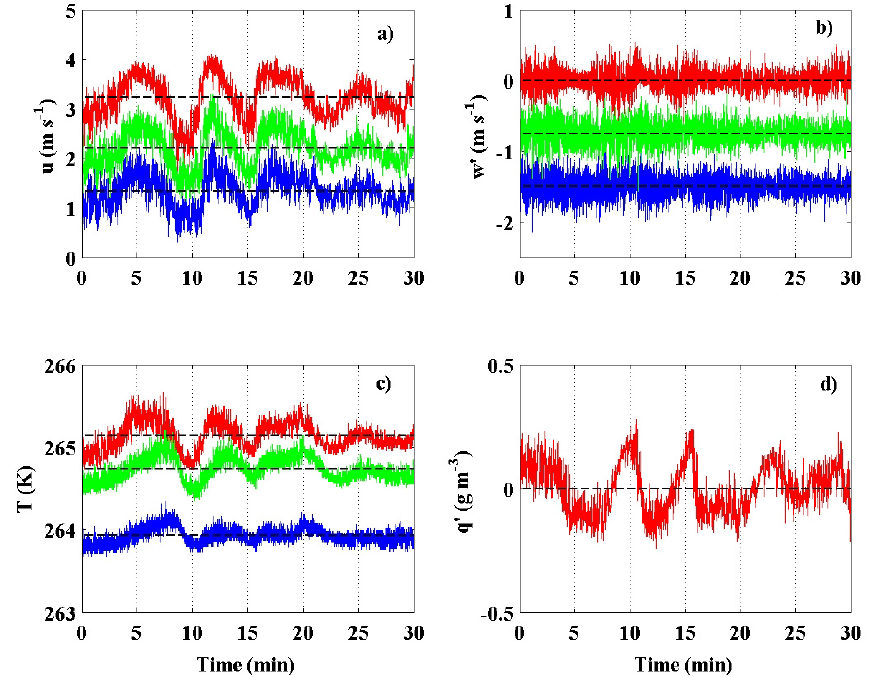
Figure 2. Time series of longitudinal ( a ) and vertical velocity components ( b ), sonic anemometer air temperature ( c ) and fluctuations in water vapour concentration ( d ) for a selected but uncommon case of a “cleaner” wave (Wave 1). The time series were collected on the 24 November 1993 at 18:00 (local time) and were associated with a drainage wind from the Priestley glacier (Sector 1). The different colours refer to the different levels of measurement: red (10 m), green (4.5 m), blue (2 m). The black dashed lines refer to the mean values. Note that in Figure 2a,b, the time series relative to the lowest levels (green and blue lines) have been artificially shifted for better visualisation